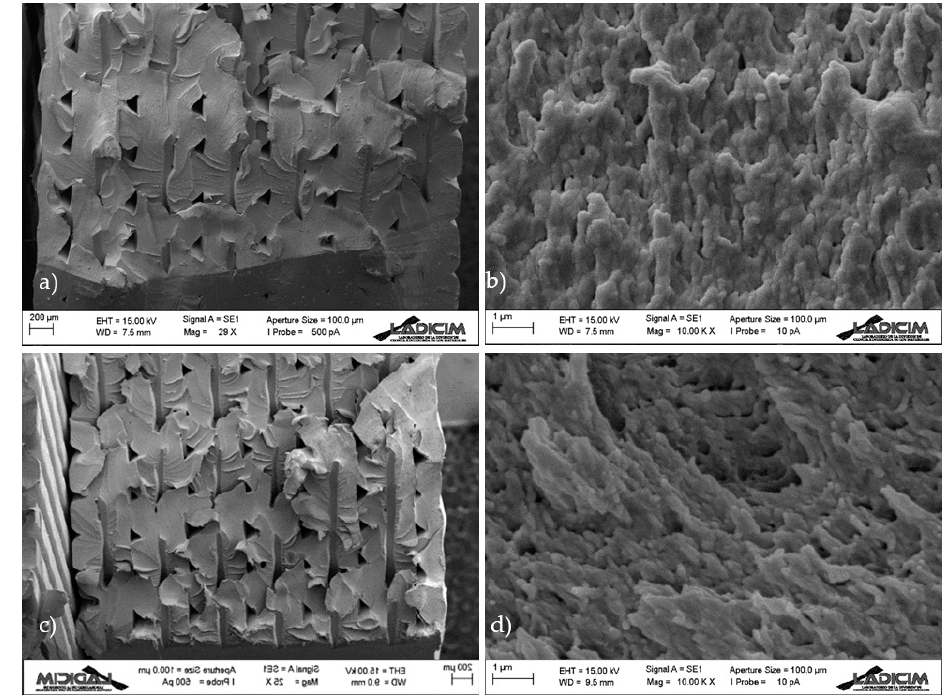
Figure 8. SEM images obtained from 30/ − 60 samples; ( a ) overall view of cracked specimen; ( b ) detail of fracture micromechanisms at the crack front; ( c ) overall view of specimen with a notch radius of 2 mm; ( d ) detail of fracture micromechanisms at the defect front.